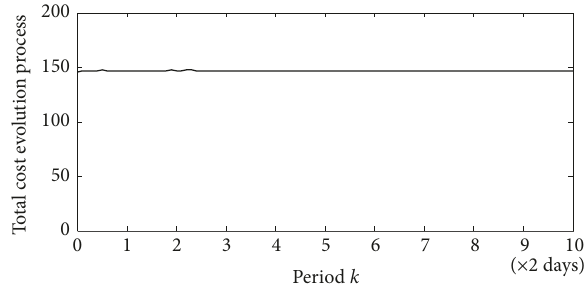
Figure 5: Evolution process of total cost under the first initial inventory statuses ( ×10 7 yuan).